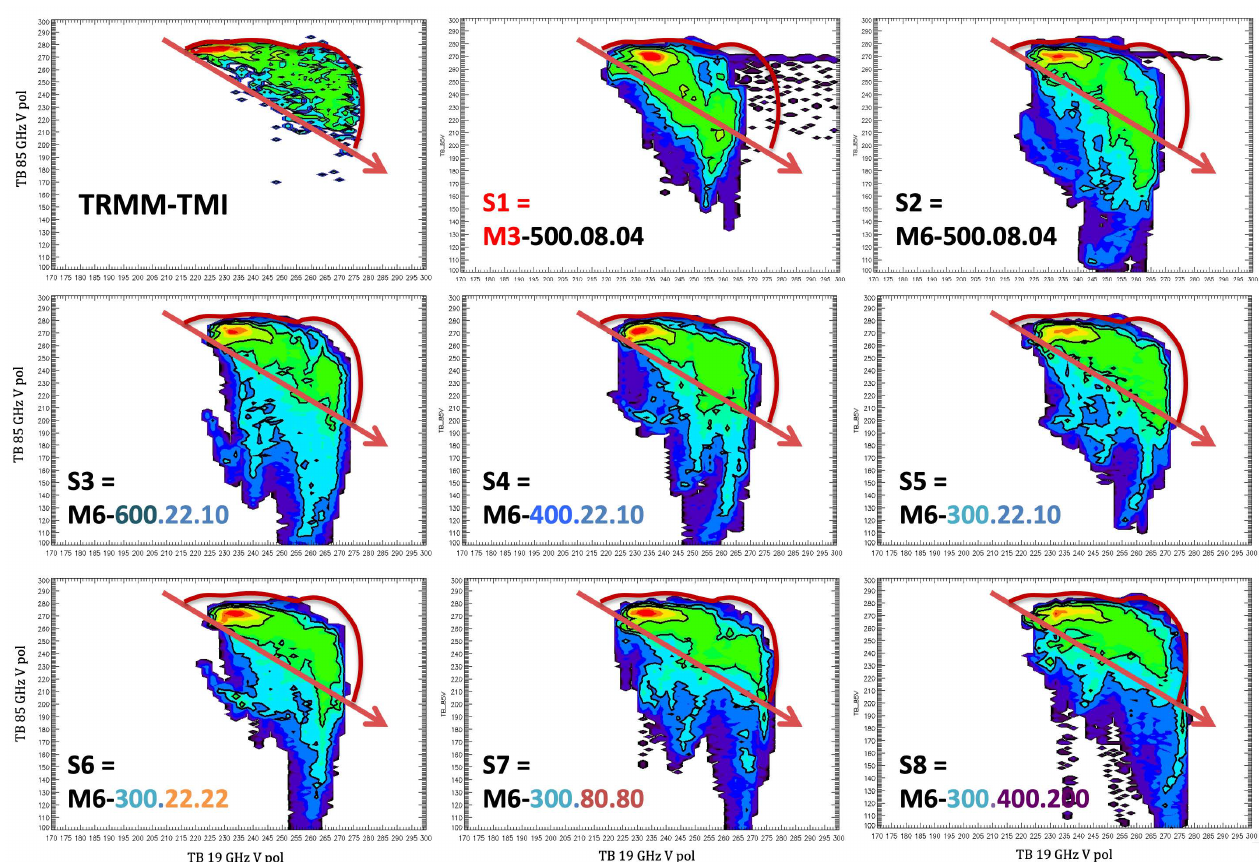
Figure 9. Joint probability density function distribution between the brightness temperatures at 19 GHz V-pol (x axis) and 85 GHz V-pol (y axis). The red arrow and the red curve enclose the space occupied by the joint distribution of the observed 19/85 GHz V pol brightness temperatures. The observations, and the eight different experiments, are arranged in the same order as in Figure